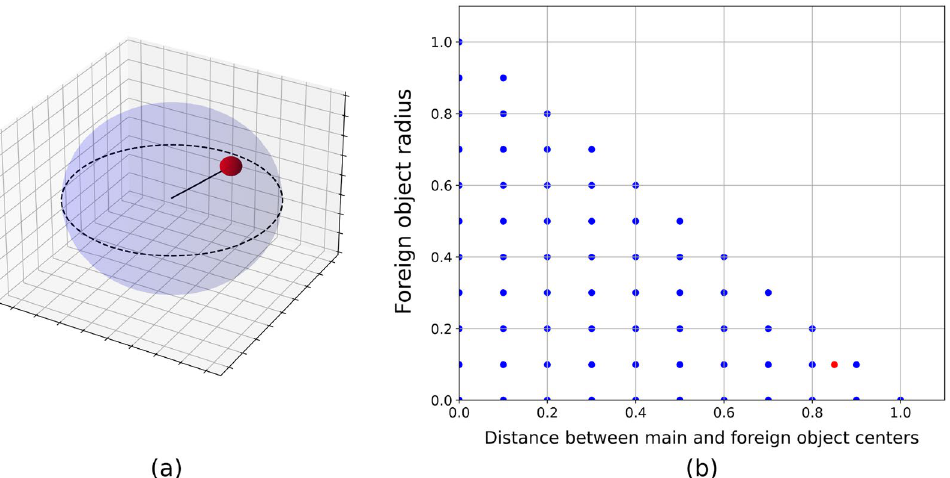
Figure 2. Example of FOD problem where a small ball is located inside a bigger one. Each sample can be described using four parameters, namely radius of the inner ball and three coordinates of the vector connecting centers of the objects. ( a ) One possible sample of this dataset. ( b ) Subspace of configuration space corresponding to the fixed polar and azimuthal angles. The configuration shown on subfigure ( a ) is marked as a red dot in this